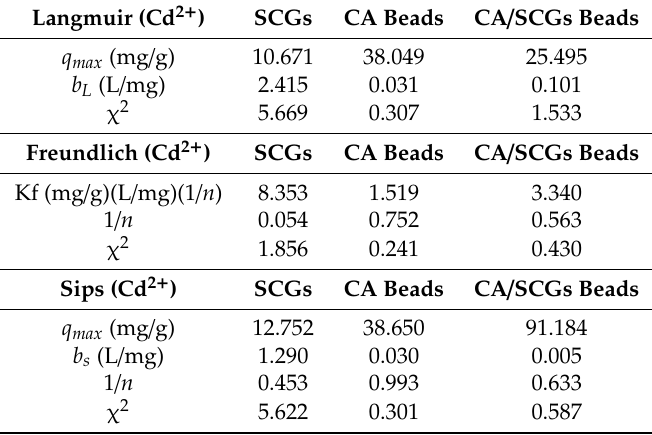
Figure 11. Plots of the results of the adsorption models for each adsorbent and the experimental values for cadmium: ( a ) CA beads and ( b ) CA–SCG beads. Table 2. Adsorption isotherm constants and chi-square test χ 2 values for each model (Cd 2 + ).